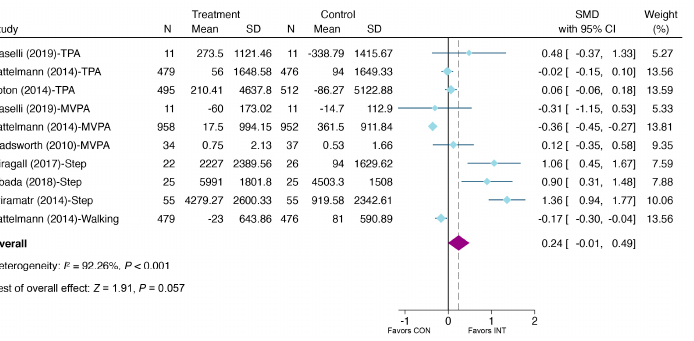
Figure 5. Meta-analysis of effects of e-health interventions on PA at follow-up versus control [37,44,51,53,54,57,62].